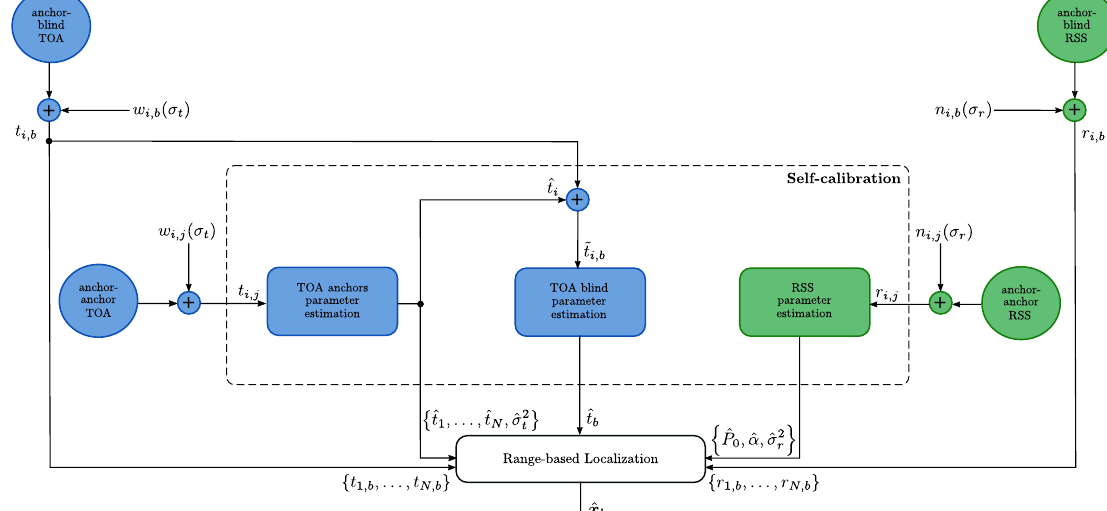
Figure 1. Block diagram of the proposed hybrid time of arrival (TOA)/received signal strength (RSS) range-based localization with self-calibration.